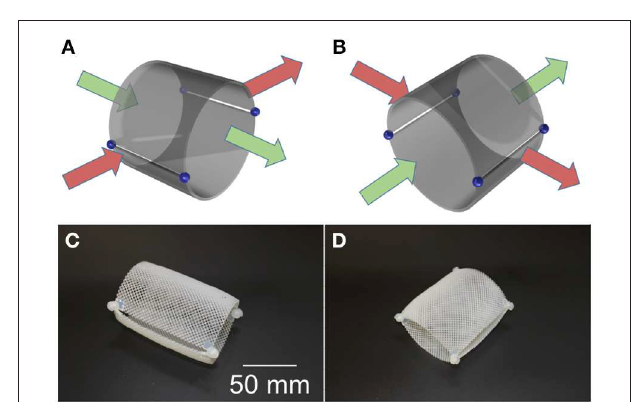
FIGURE 12 | A bidirectional bistable valve concept, made by attaching two shells with ball-and-socket joints. A diagrammatic explanation is shown in (A,B) , with the two states of a physical demonstrator shown in (C,D)